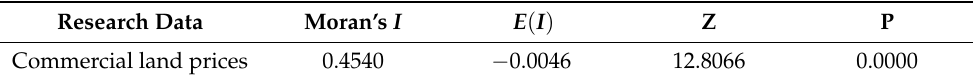
Table 6. Estimated global Moran’s I index of commercial land prices in Hangzhou’s main district from 2006 to